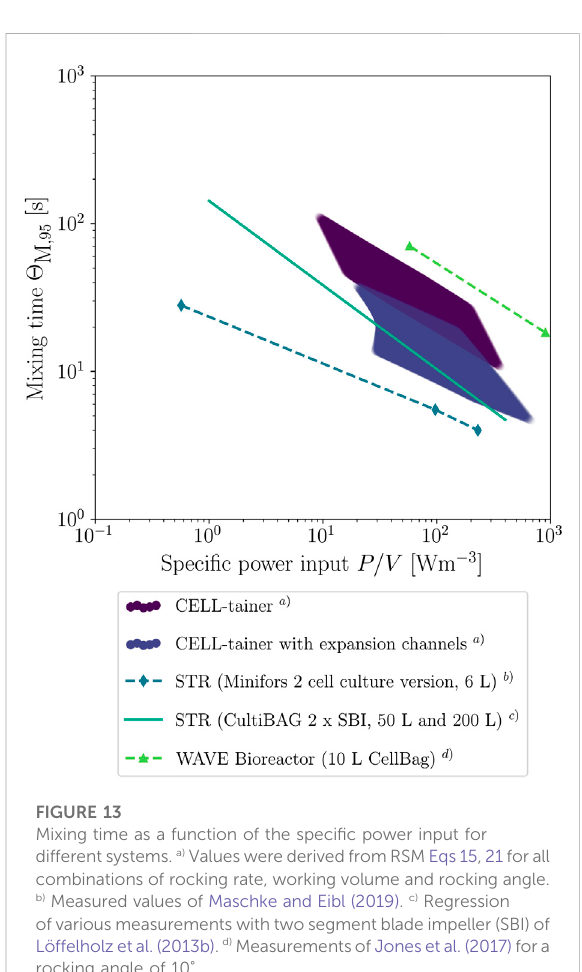
FIGURE 13 Mixing time as a function of the speci fi c power input for differentsystems. a) ValueswerederivedfromRSMEqs15,21forall combinations of rocking rate, working volume and rocking angle. b) Measured values of Maschke and Eibl (2019). c) Regression of various measurements with two segmentblade impeller (SBI)